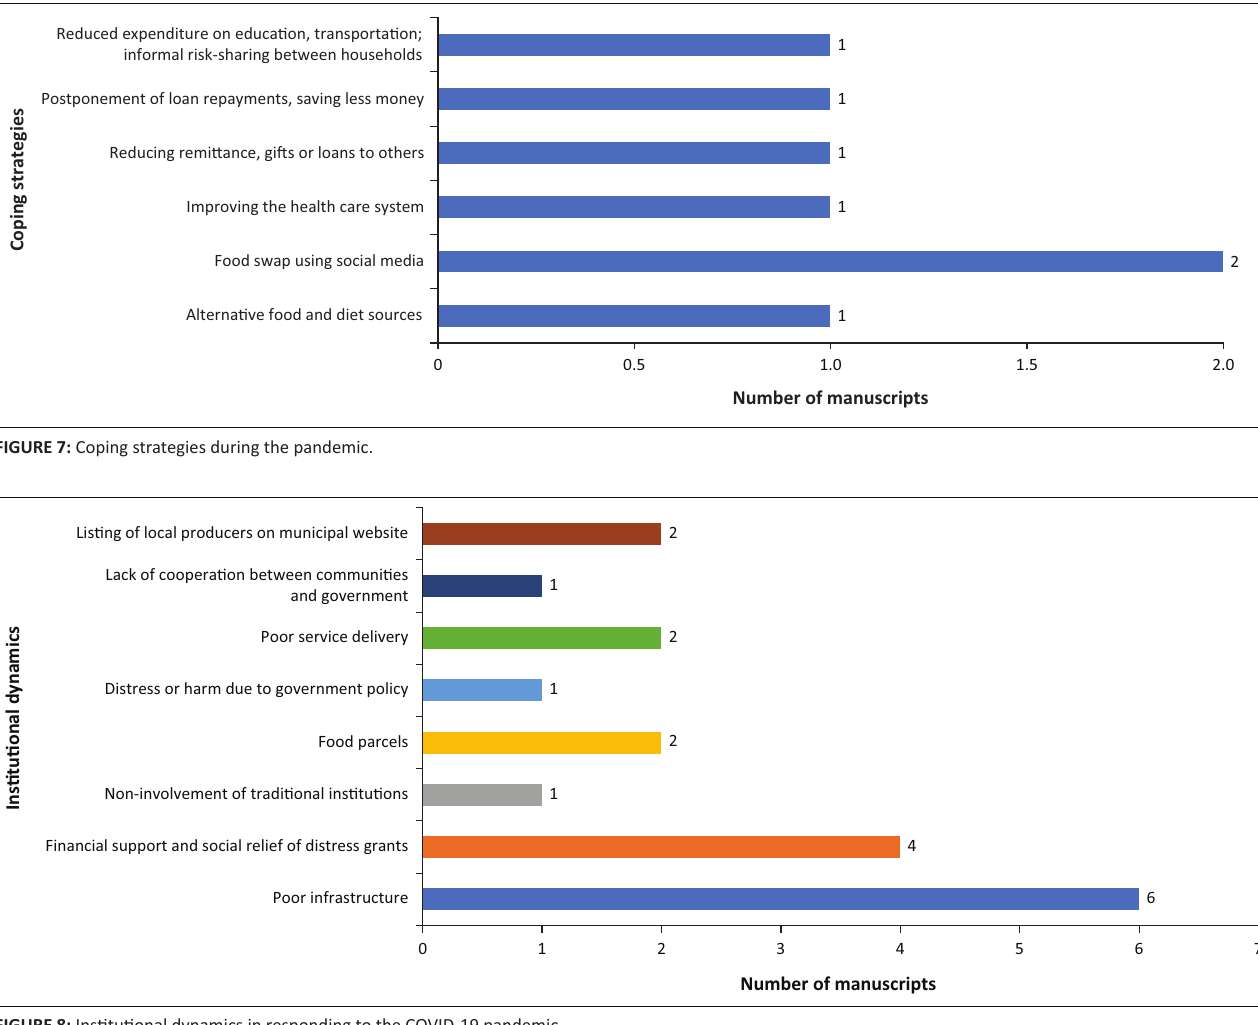
FIGURE 8: Institutional dynamics in responding to the COVID-19